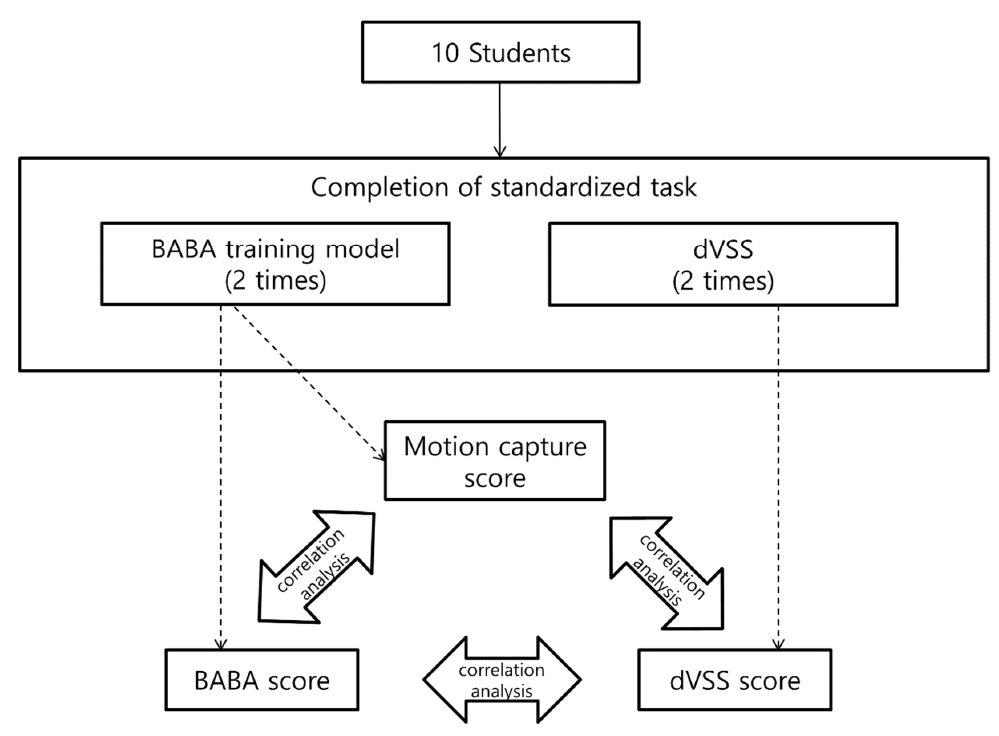
Figure 1. Study design. BABA: bilateral axillo-breast approach; dVSS: da Vinci Skills Simulator.